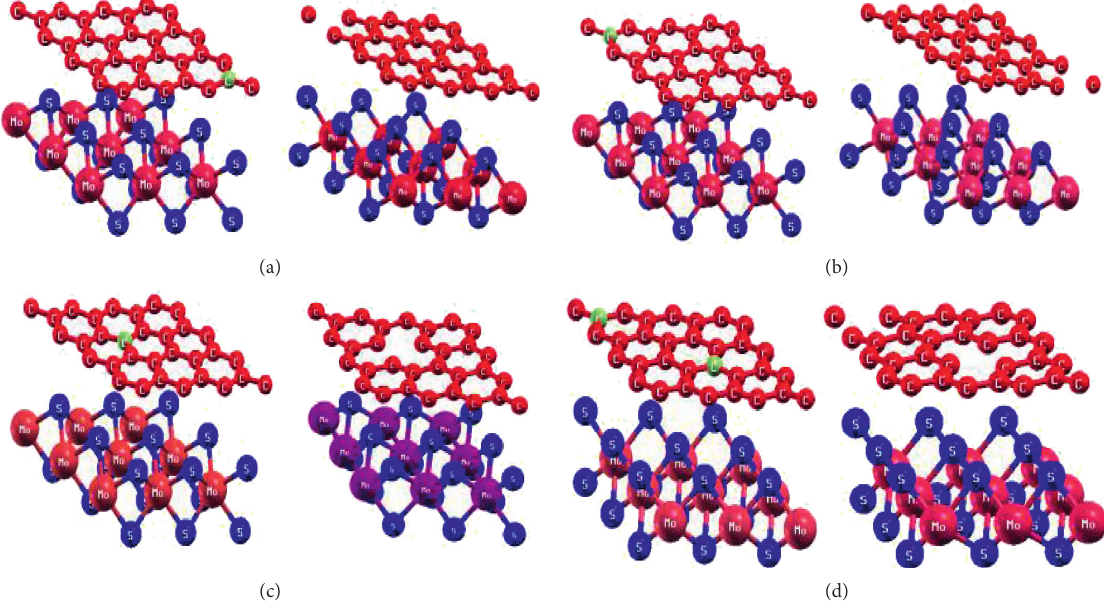
Figure 2: Optimized and relaxed structures of C sites vacancy defects in HS-G/MoS